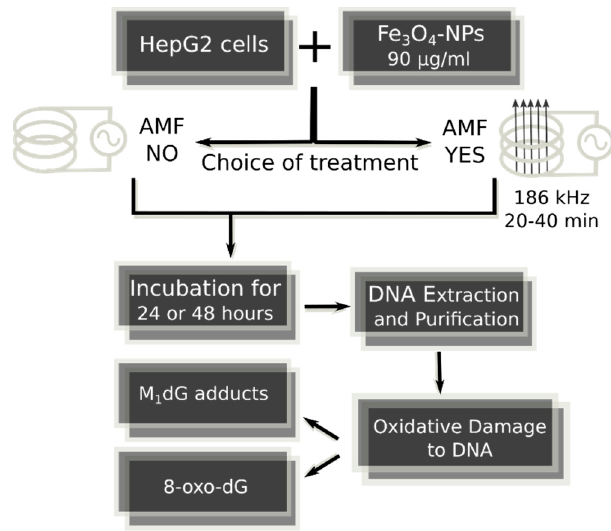
Figure 5. Strategy protocol of analytic research aimed to examine the genotoxic effects of Fe 3 O 4 - nanoparticles at select dosage and incubation times in presence or absence of magnetic therapy in HepG2 cells.